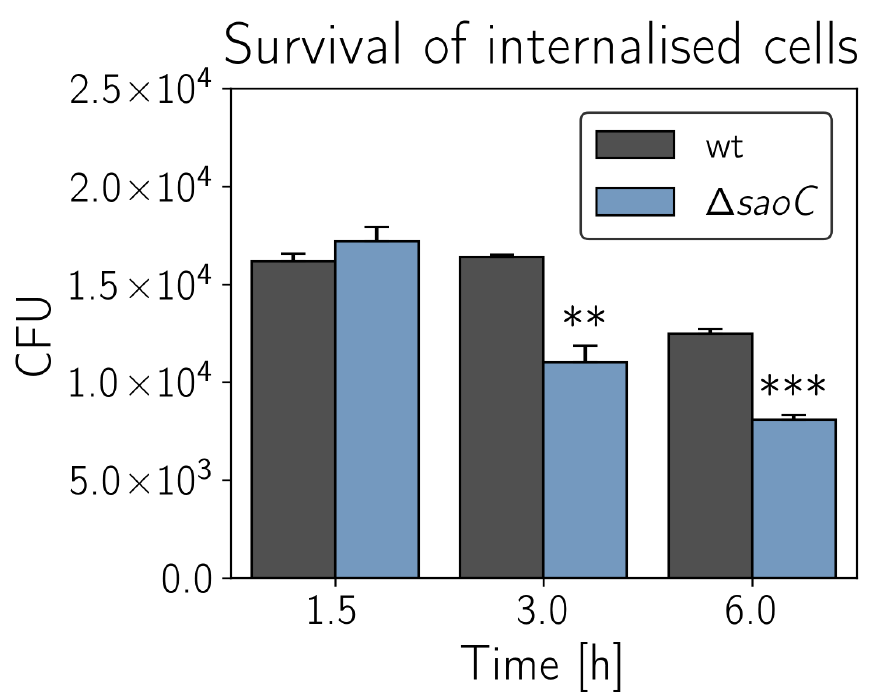
Figure 7. Survival of RN4220 strain knockout mutant ∆ saoC in human dermal fibroblasts. RN4220 ∆ saoC reproducibly manifests decreased survival of cells internalised to human fibroblasts ( n = 3). The survival is lower by 25–30% to that of the wild type RN4420 in the third and sixth hour after exposure of fibroblasts to bacterial cells. ** p ≤ 0.010, *** p ≤ 0.001.